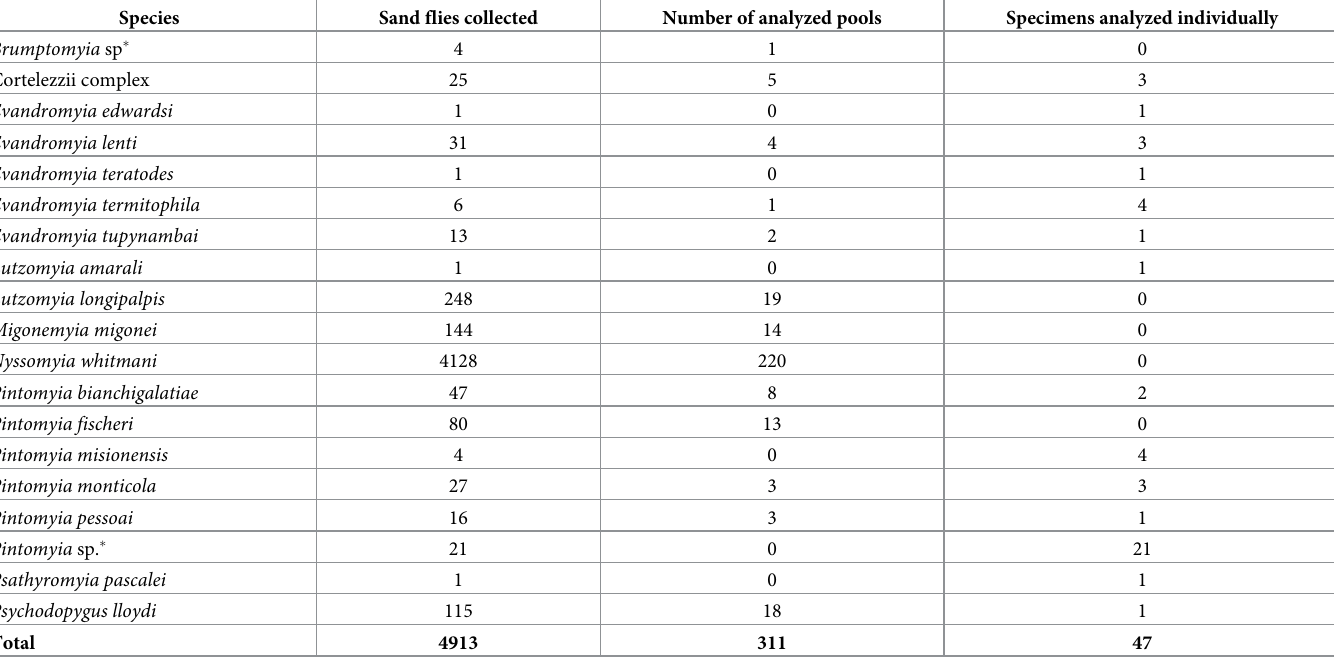
Table 2. Sand fly organized by species that were analyzed individually and in pools collected in Casa Branca, Brumadinho, Minas Gerais, from May 2013 to May 2014. Species